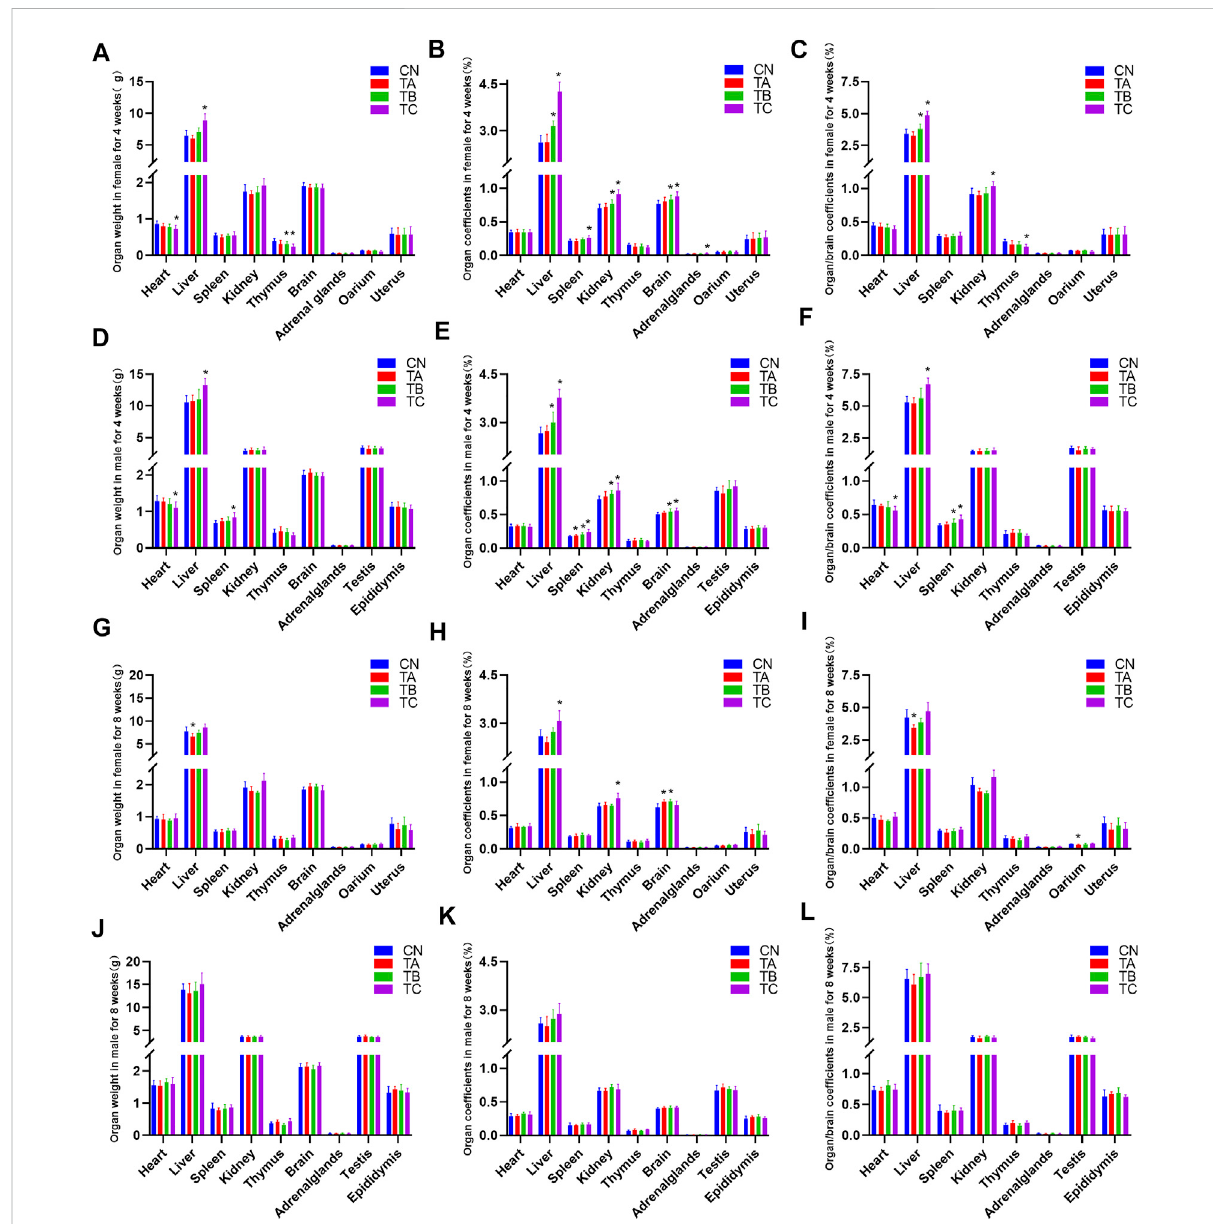
FIGURE 3 EffectsofthreedifferentdosesofQZZDonabsoluteorganweights,organcoef fi cientsandorgan/braincoef fi cientsinmaleorfemaleratsatthe endofthetreatmentperiodorrecoveryperiod.Inthetreatmentperiod, n =12infemalegroup( n =10inTC) (A – C) ,and n =12inmalegroup (D – F) .In the recovery period, n = 6 in each group, including six females (G – I) and six males (J – L) . Compare with the control group * p <